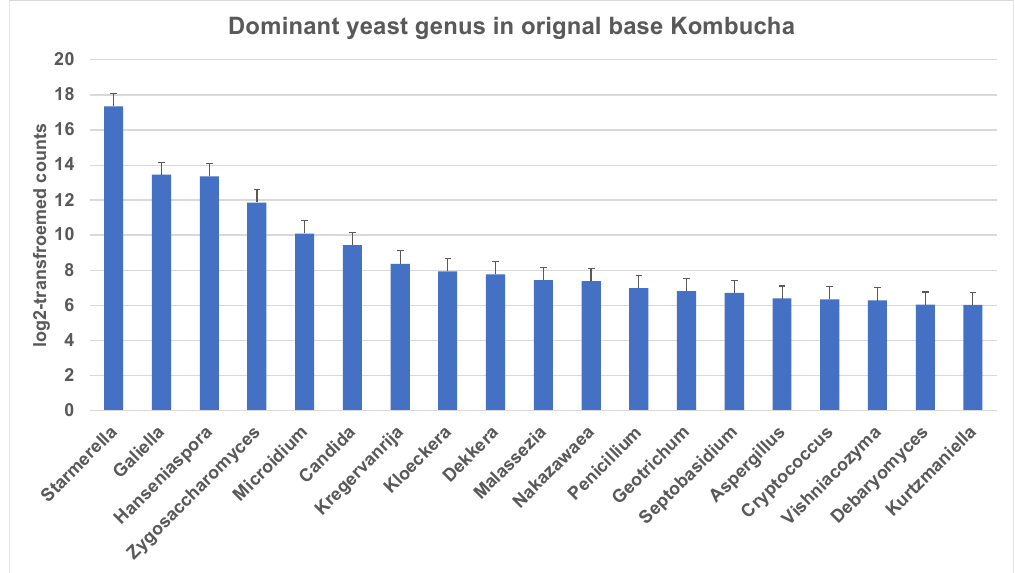
00.511.522.533.5